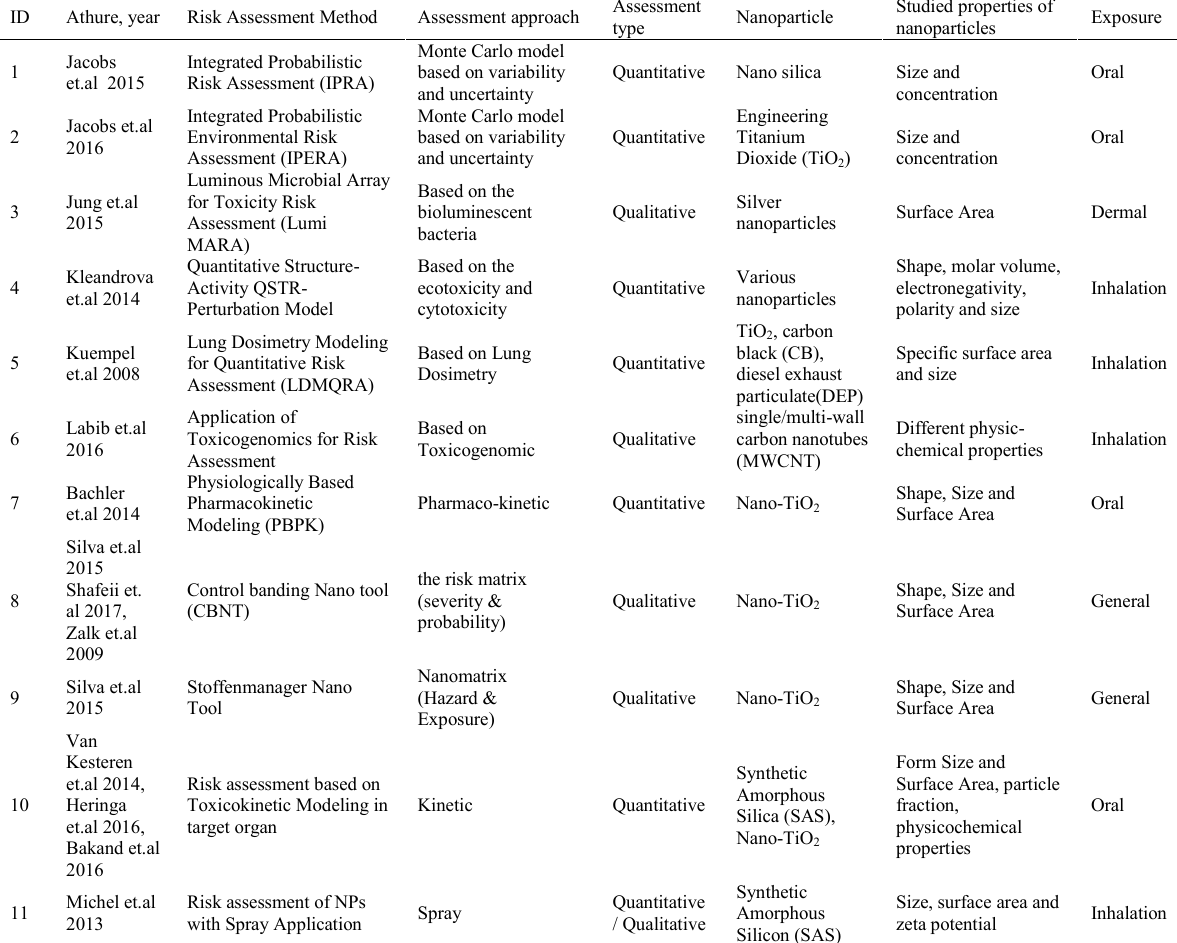
Table 4. Summary of risk assessment methods based on the type of NPs and evaluation approach ID Athure,